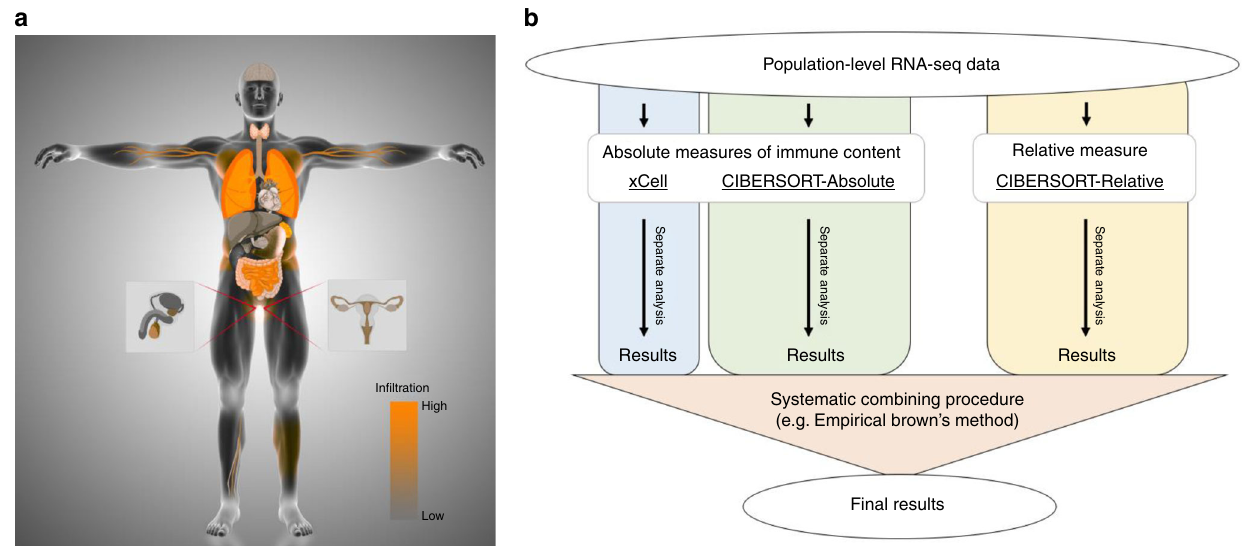
Fig. 1 Study overview. a Using deconvolution algorithms and population-level transcriptomes, we estimated the amount of speci fi c immune cell types in 11,141 samples from the Genotype-Tissue Expression project. This data set spans 46 distinct tissue types. We visualize the total amount of in fi ltration, as calculated by the scaling factor in CIBERSORT-Absolute, in each of these tissues. Source data are provided as a Source Data fi le. b A graphical overview of downstream statistical analysis. Immune content was estimated by using three different algorithms. xCell estimates various subtypes of CD8 + T cells, CD4 + T cells, B cells, dendritic cells, macrophage polarization states, innate immune cells, and non-immune cells. CIBERSORT, which only measures immune cells, estimates fewer subtypes and instead distinguishes between resting and activation states of major cell types. Both algorithms utilize different reference gene sets. Statistical analyses were performed on each of these three estimates separately. The fi nal results were obtained by combining the different separate